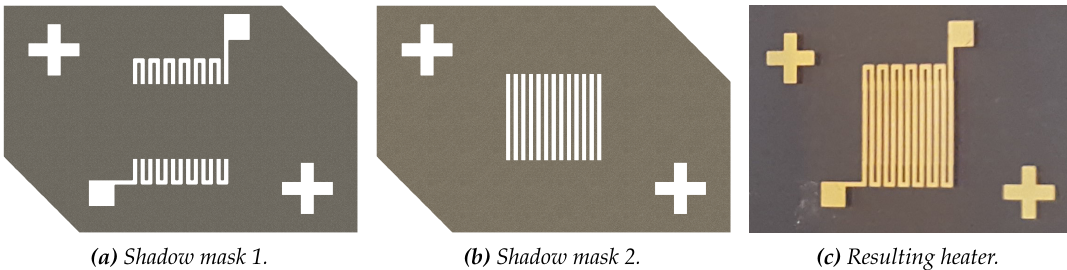
Figure 7. Panels ( a ) and ( b ) show the SolidWorks drawings of shadow masks 1 and 2, respectively. Panel ( c ) shows the resulting metal track after deposition. The crosses are used for alignment under an optical